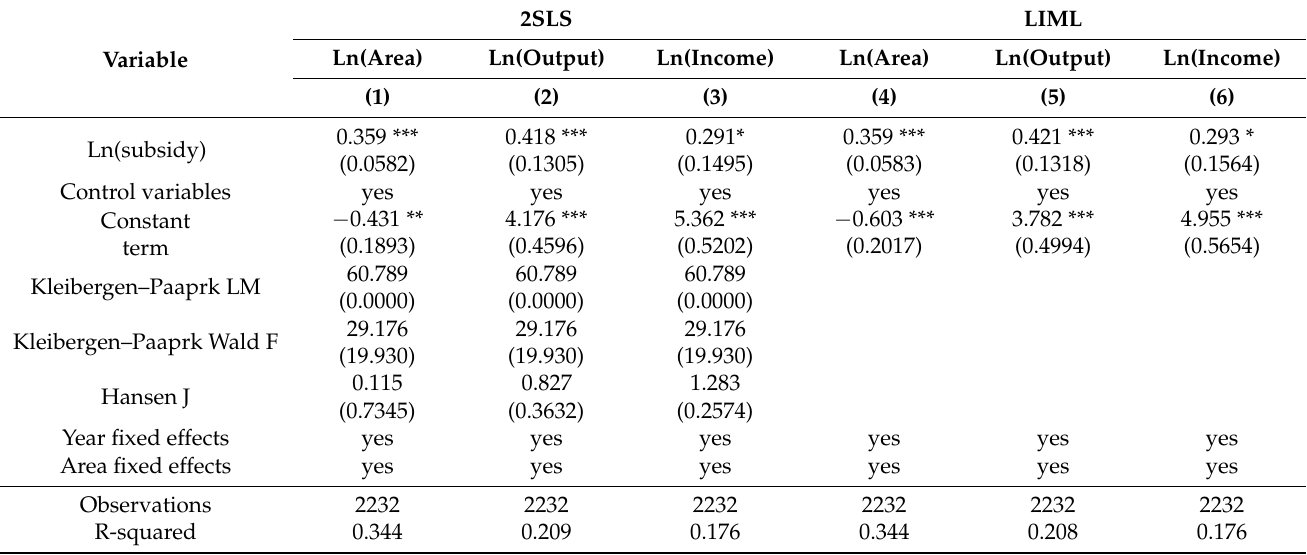
Table 3. Regression results obtained by instrumental variable